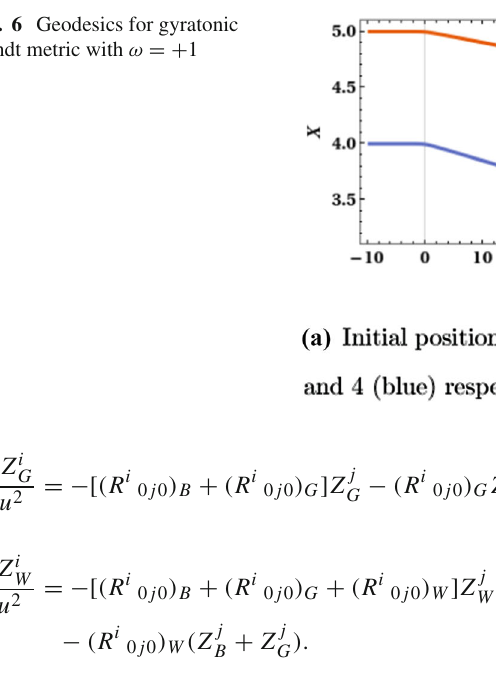
Fig. 6 Geodesics for gyratonic Kundt metric with ω = +